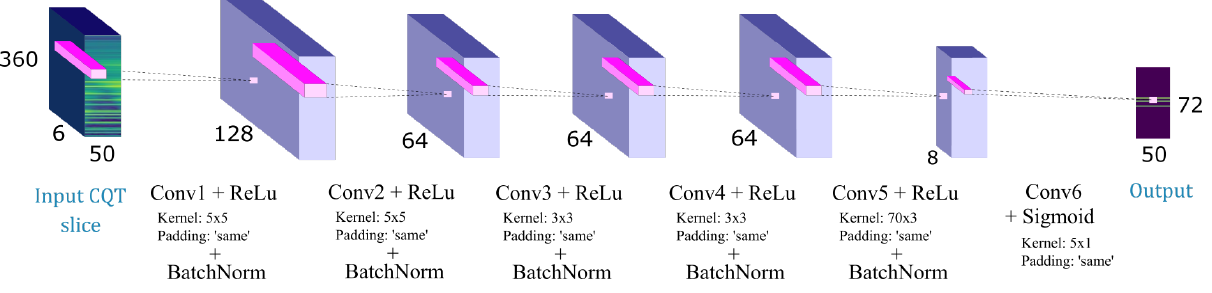
Figure 5. Neural Network (NN) structure used in our model for polyphonic